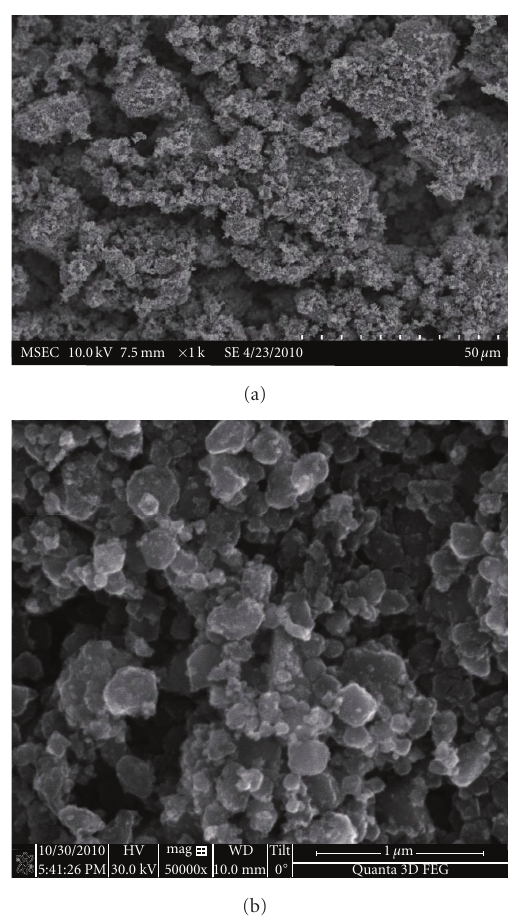
Figure 3: (a) TiO 2 , and (b) Sn . 10 Ti . 90 O 2